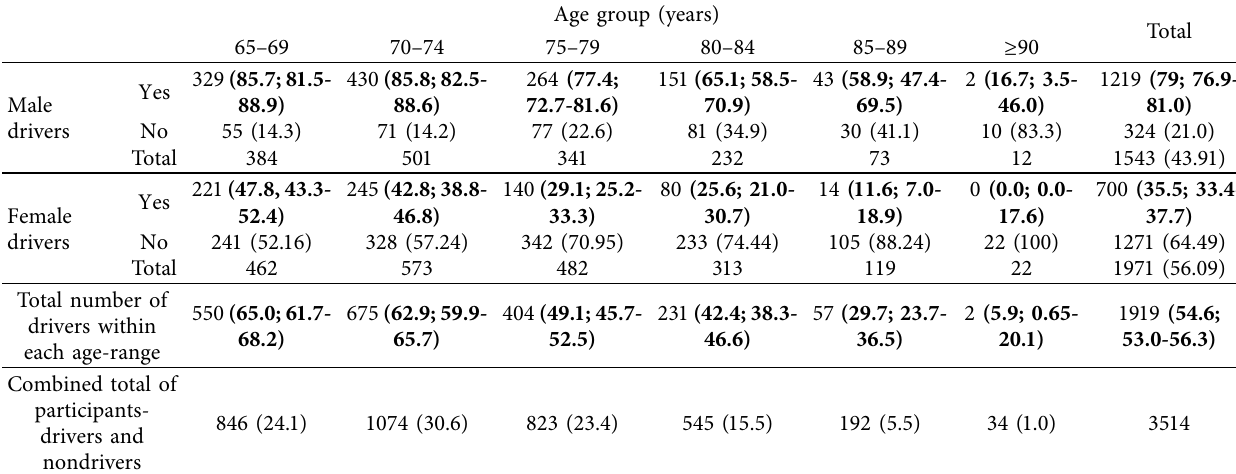
Table 1: Age- and gender-specific prevalence of